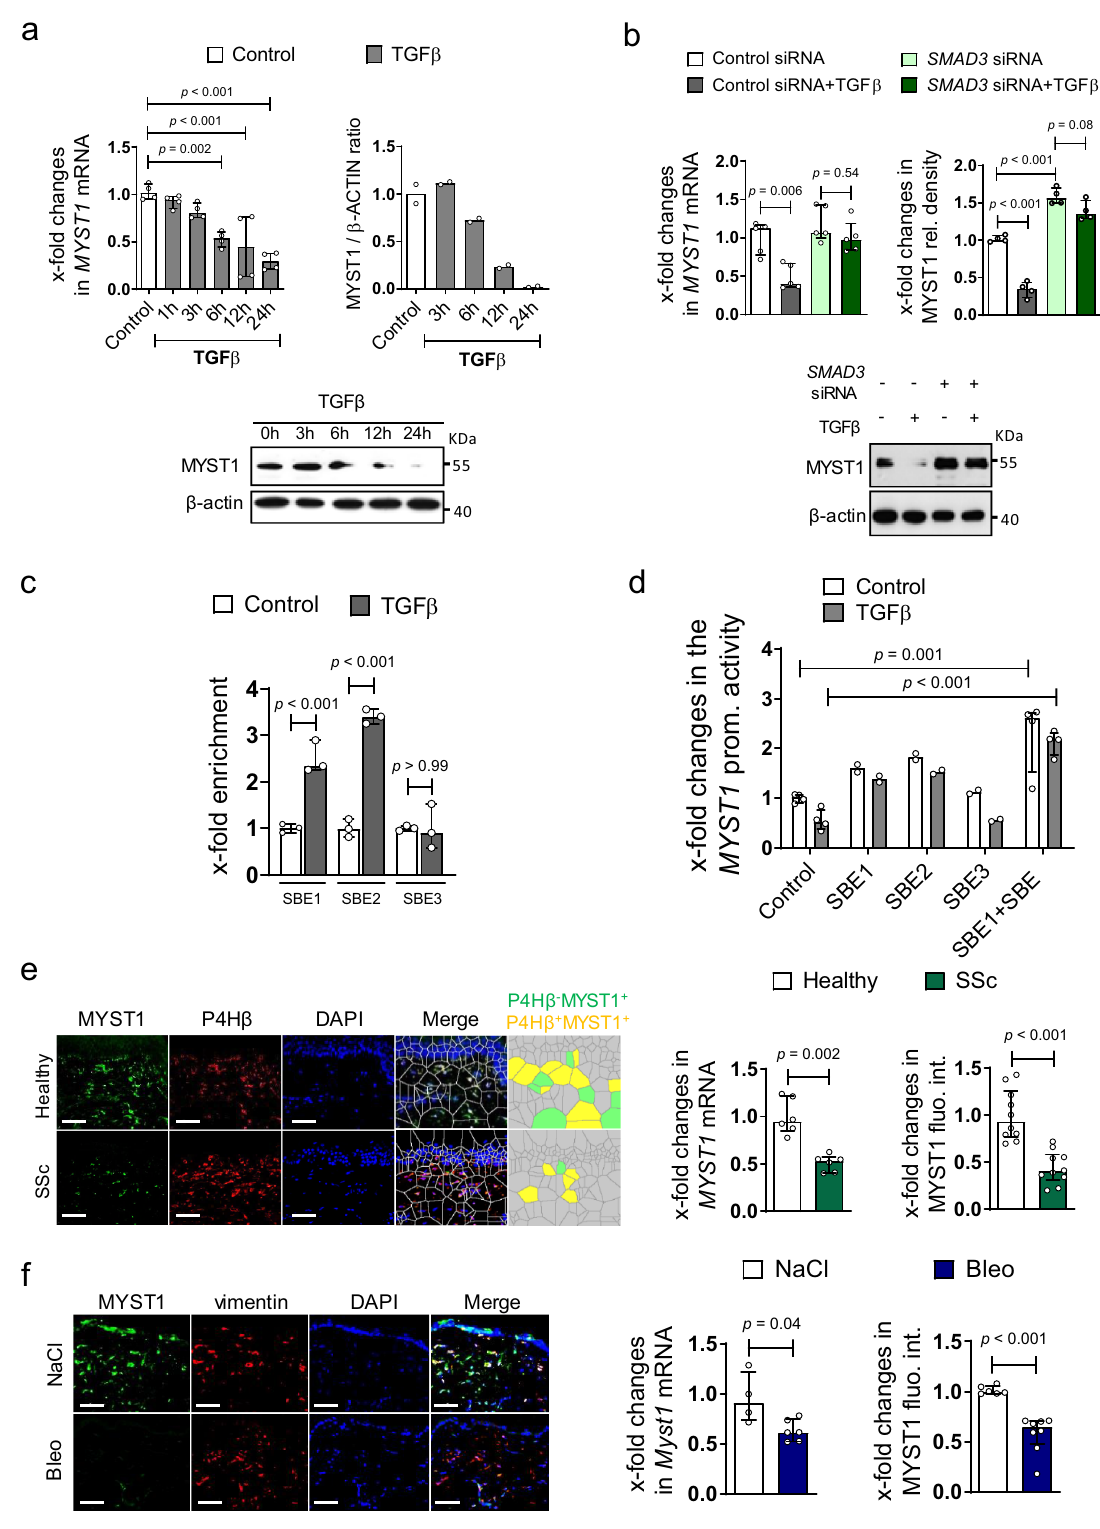
autophagy also decreased dermal thickness, myo fi broblast counts and hydroxyproline content to below pretreatment levels, indicating regression of bleomycin-induced skin fi brosis. Overexpression of MYST1 ameliorates experimental fi brosis . Based on the potent inhibitory effects of MYST1 on